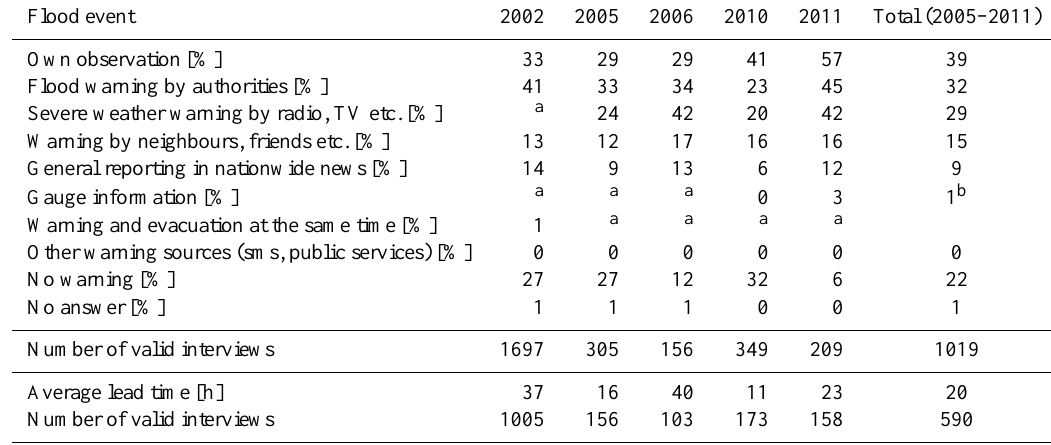
Table 6. Answers to the question: “How did you become aware of the danger of flooding?” given in percentage of all interviewed people per flood event (multiple answers possible) and average lead time per subsample.